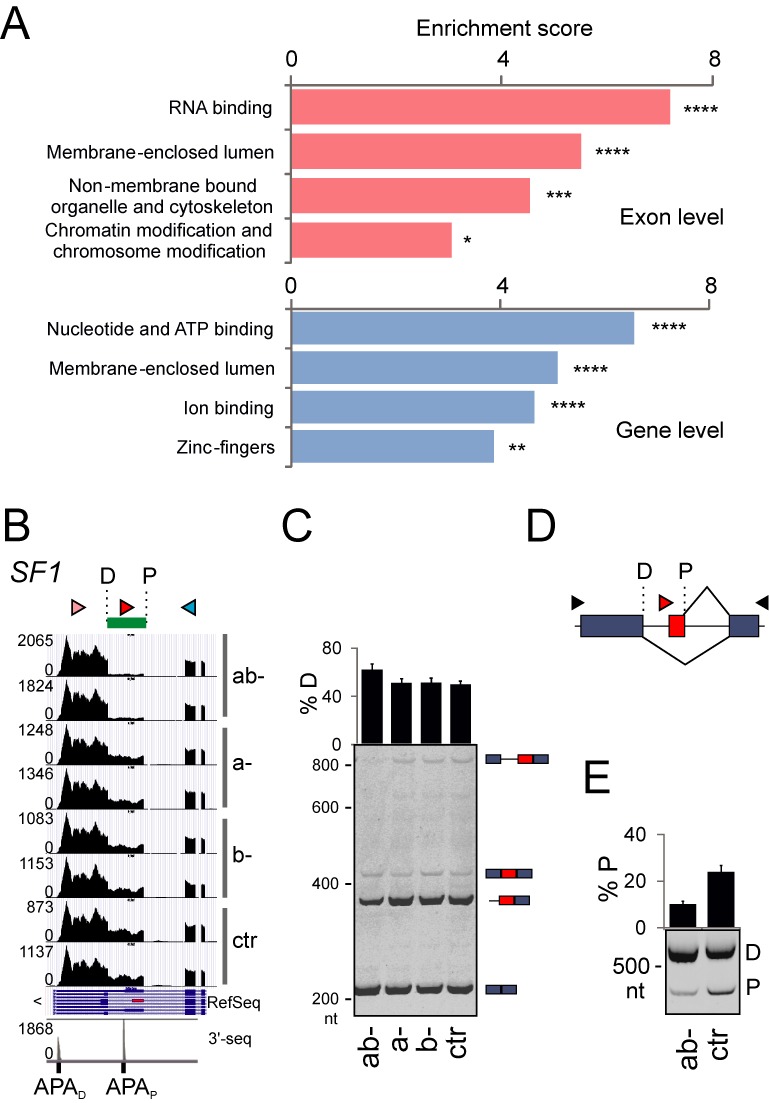
U2AF(35)-regulated exons are overrepresented in genes encoding RNA-binding proteins. (A) Functional enrichment analysis using DAVID (35). Asterisks denote the FDR significance (*P < 0.05; **P < 0.005; ***P < 0.0005; ****P < 0.00005). (B) Regulation of alternative 3′ss site usage of SF1 by U2AF(35). P, D, proximal and distal 3′ss of the last SF1 intron. Arrowheads denote RT-PCR primers (Supplementary Table S4) used in panel C. The last track shows unified 3′-seq coverage from multiple tissues with the location of two APA sites (45). Supplementary Figure S12 shows their usage in various cell types; the proximal APA site is used only weakly in HEK293 cells. (C) Activation of distal 3′ss SF1 in depleted cells. RNA products are schematically shown to the right. Error bars denote SDs. (D) Schematics of the SF1 minigene. Arrowheads show primers used for RT-PCR in panel E. (E) RNA products of the SF1 minigene. Transient transfections were into HEK293 cells (mock)-depleted of U2AF35.